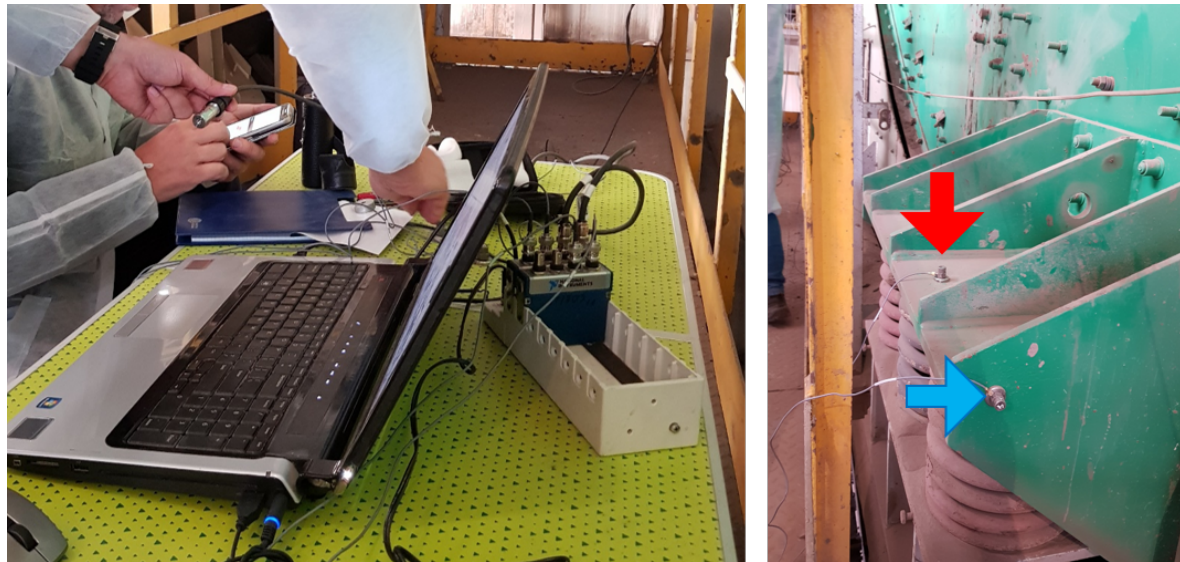
Figure 3. Computer and data acquisition card used for the experiment ( left image ) and positioning of horizontal and vertical direction sensors on the bottom right spring set ( right image ).